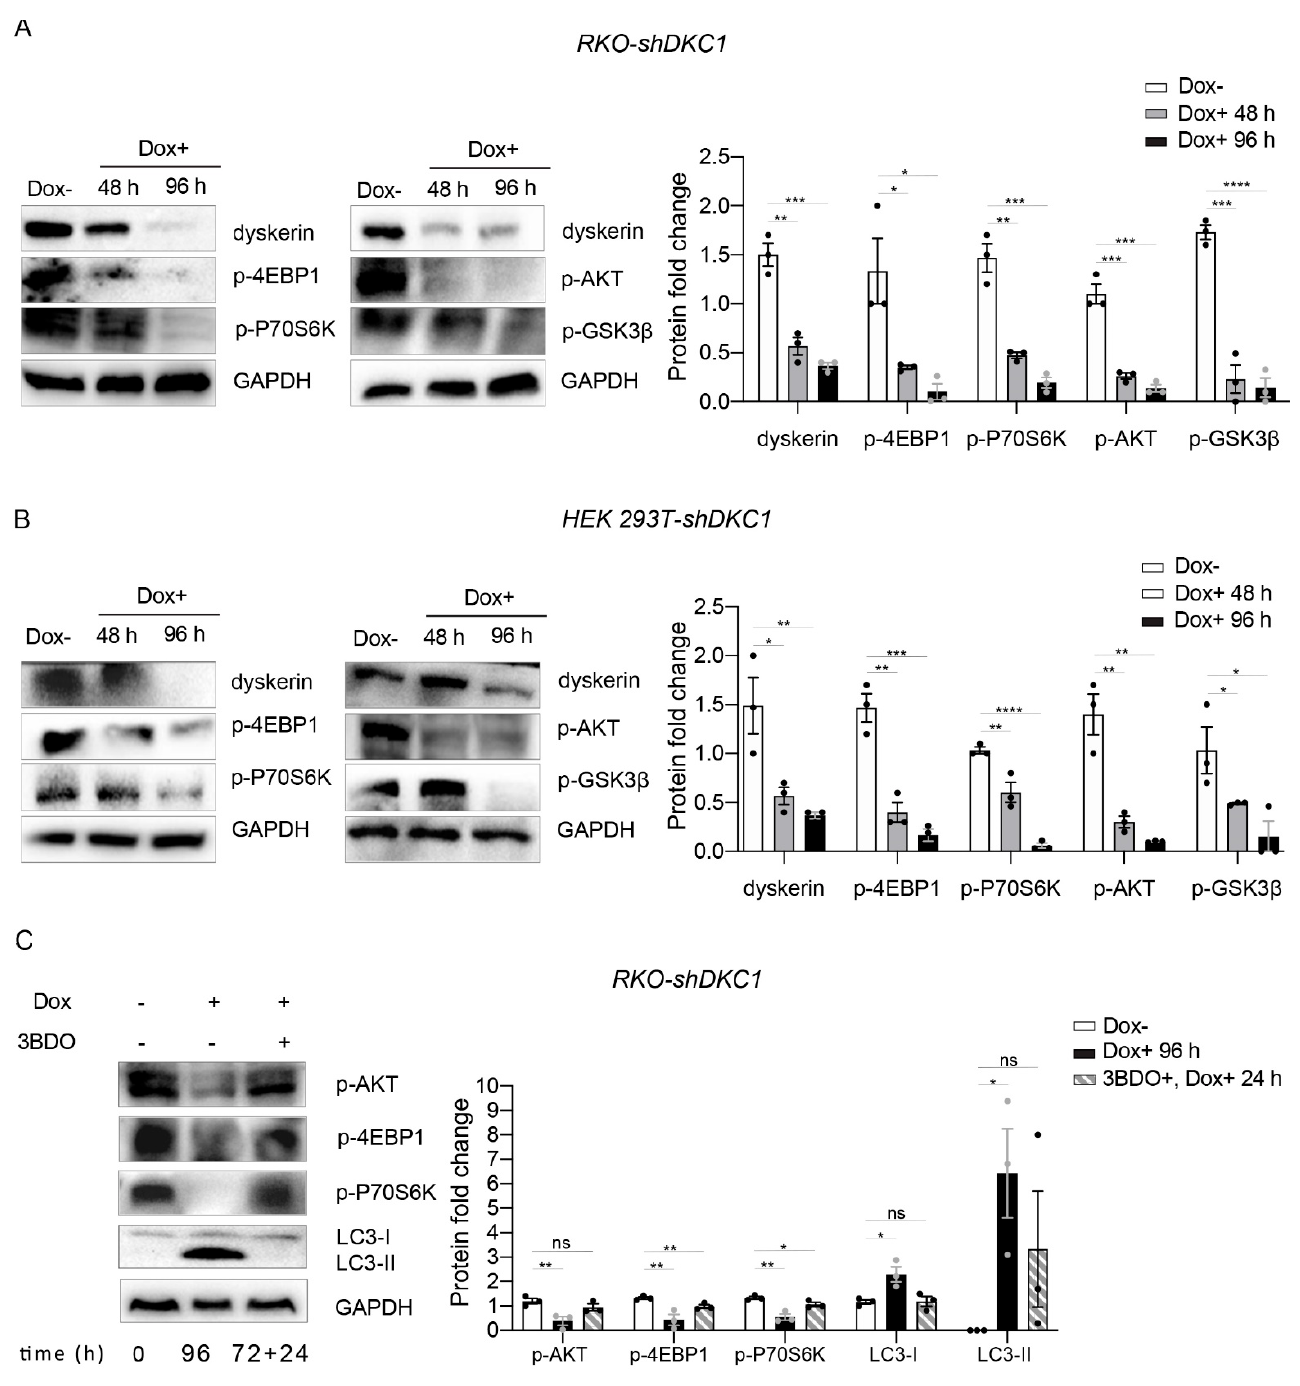
Figure 6. Dyskerin downregulation inhibits AKT/mTOR signaling. ( A , B ) Western blots showing the downregulation of p-4EBP1, p-P70S6K, p-AKT and p-GSK3 β upon dyskerin depletion. Band intensities for each protein were normalized to the band intensity of GAPDH and the results are expressed as mean ± SEM ( n = 3). ( C ) The 3BDO treatment rescued the expression levels of p-AKT, p-4EBP1 and p-P70S6K and prevented the accumulation of LC3 II. In the timeline, 72 + 24 h indicates that 72 h of Dox treatment were followed by 24 h of Dox + 3BDO treatment. For quantification, the band intensity for each protein was normalized to the band intensity of GAPDH. Results are expressed as mean ± SEM ( n = 3). An unpaired one-tailed t -test was used in pairwise comparisons with respect to the Dox– condition (**** p < 0.0001; *** p < 0.001; ** p < 0.01; * p < 0.05; ns, p > 0.05).